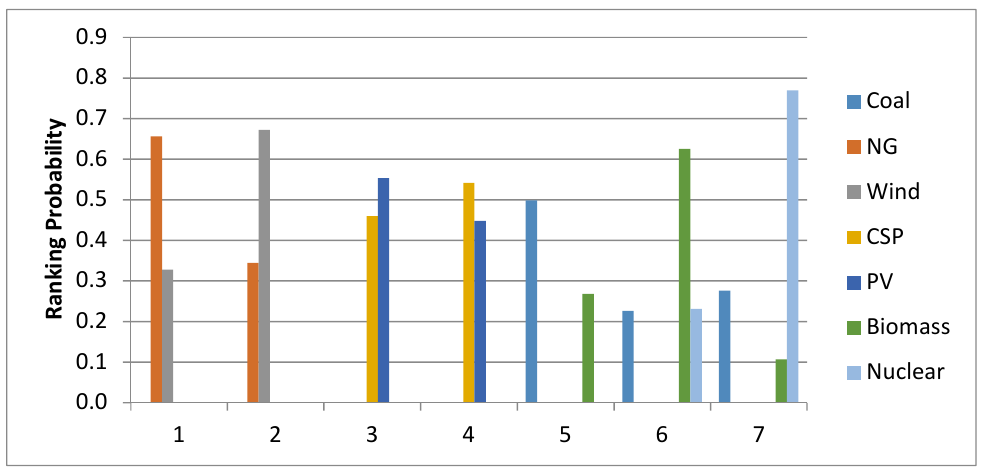
Figure 11. The probability of the simulated ranking of the technologies over 1000 observations by Monte-Carlo validation.